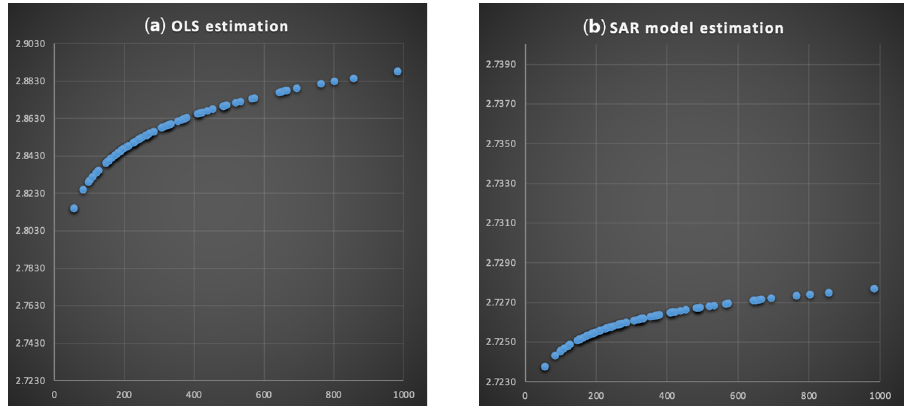
Figure 5. Estimation of the effect of distance on agricultural transport costs.